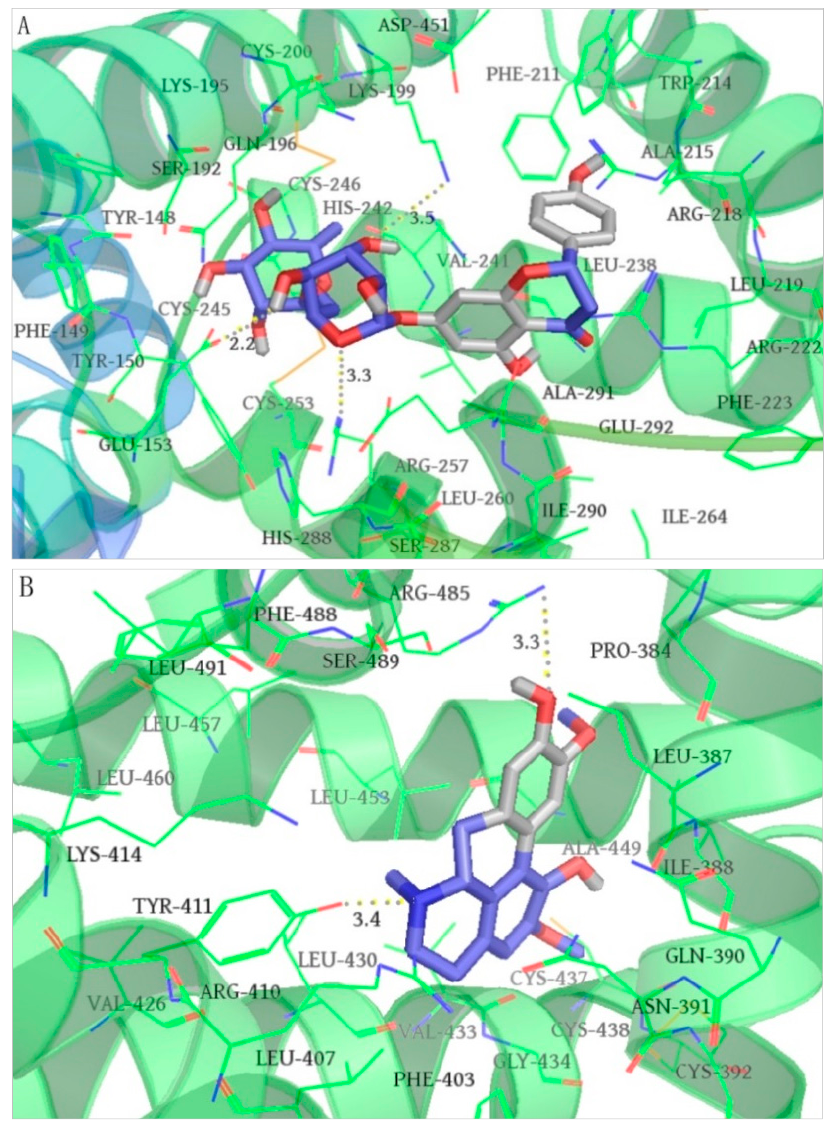
Figure 5. Molecular docking of narirutin docked to site I ( A ) and norisoboldine docked to site II ( B ) of human serum albumin (HSA), respectively (Ligands were shown in stick form and gray dashed lines were hydrogen bonds. The figure was prepared with PyMol. The interactions between bioactive ligands and binding sites were detailed in the article).